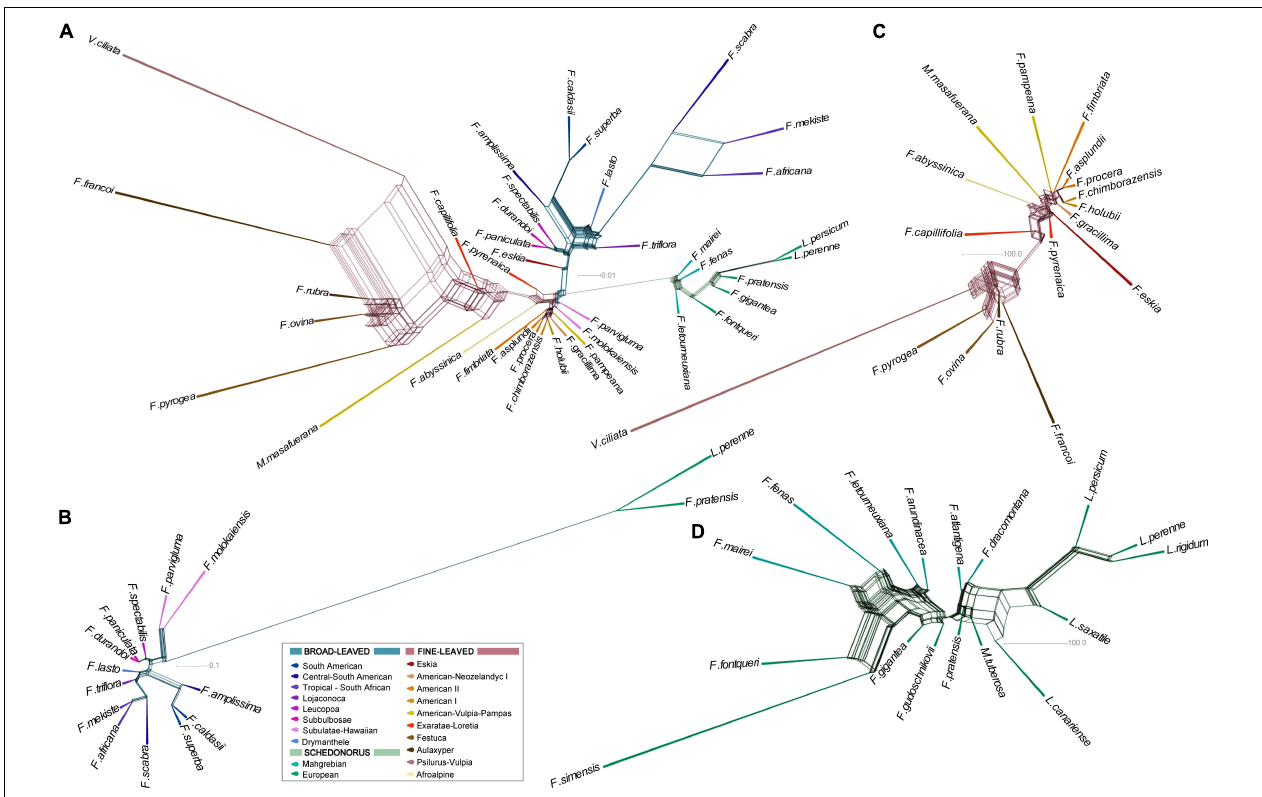
FIGURE 4 | Evolutionary networks based on standardized repeat data sets obtained from the comparative RE2 analysis of the four Loliinae evolutionary groups: (A) Loliinae, (B) broad-leaved (BL) Loliinae, (C) fine-leaved (FL) Loliinae, and (D) Schedonorus. The networks were constructed from distance-based NJ trees computed with pairwise Euclidean distances between samples (see text). Color codes of Loliinae lineages are indicated in the respective charts. Scale bar: number of mutations per site.